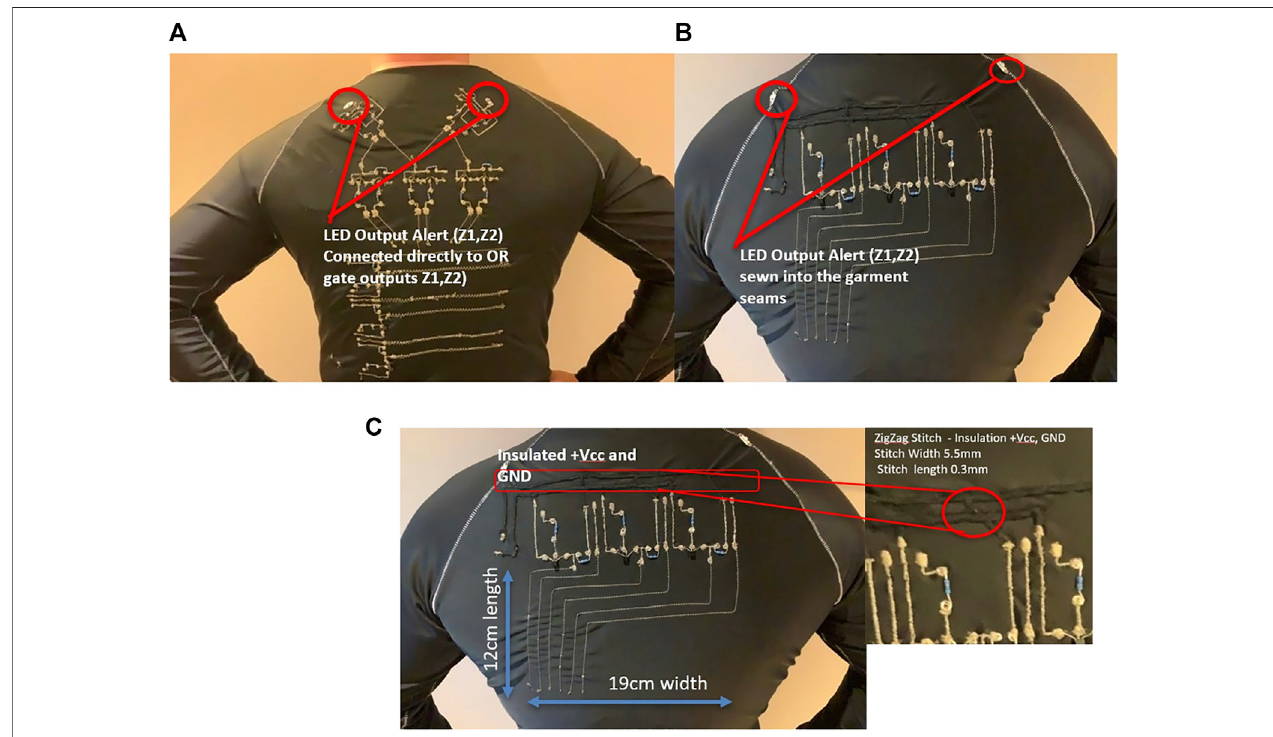
FIGURE 8 | LED alert noti fi cation: (A) single-layer LED Z1 and Z2 alerts, (B) multilayer LED Z1 and Z2 alerts, and (C) +Vcc and GND connections insulated using a compressed zigzag stitch. Input/Not plane dimensions.